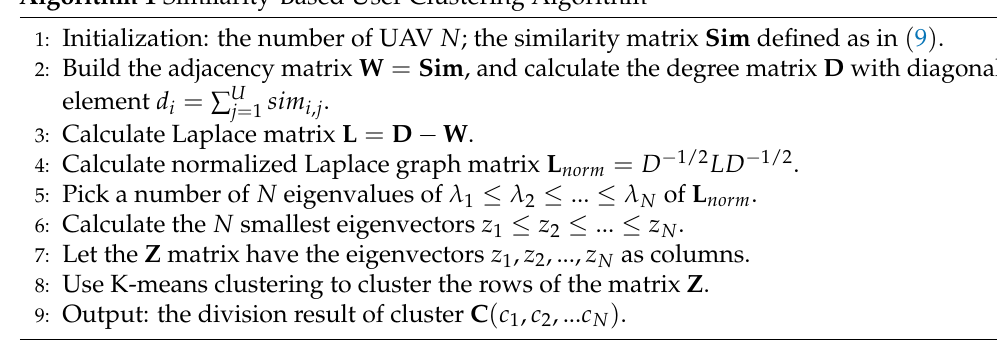
Algorithm 1 Similarity-Based User Clustering